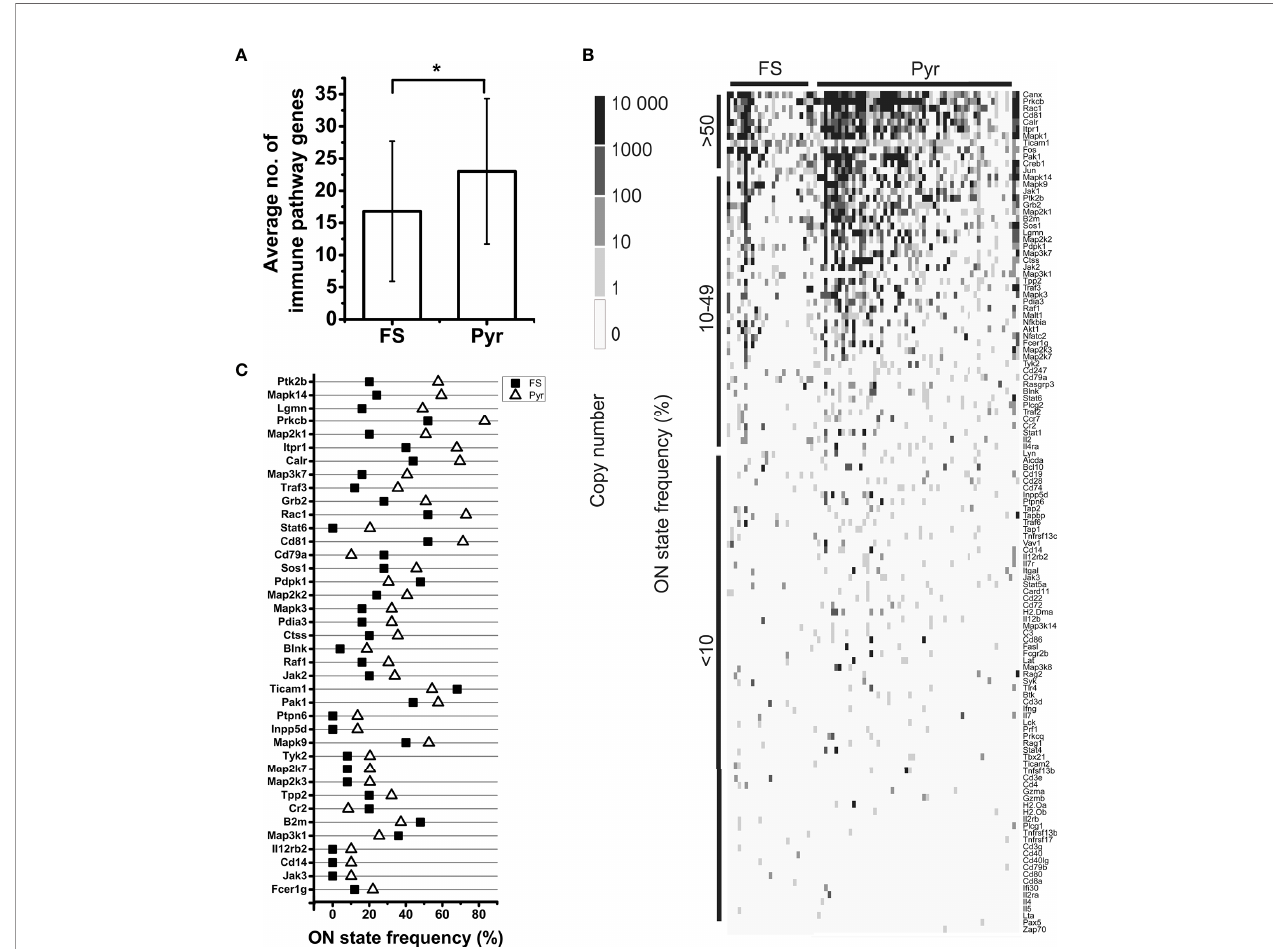
FIGURE 5 | Analysis of mRNA expression of immune process proteins by FS and Pyr cells. Bar plot shows the average number of expressed immune pathway genes in FS and Pyr cells, error bars represent SD; Pyr cells expressed signi fi cantly higher number of immune pathway genes ( P = 0.022, two-sample t -test) (A) . Heatmap of immune pathway gene expression in single neurons; genes are ordered based on their ON state frequencies; gray scale shows the copy number of mRNAs in each cell (B) . ON state frequencies of genes in FS and Pyr cells are shown; only those genes are listed, which have at least 10% difference in their ON state frequencies between the two cell types (C) . *P <